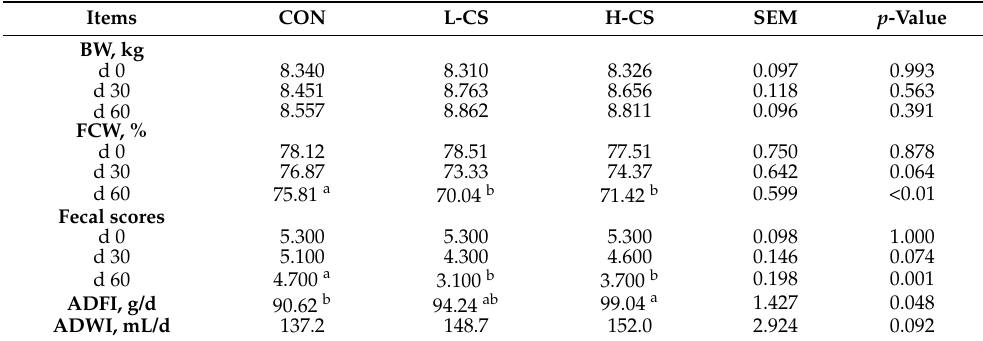
Table 2. Effect of chitosan on physical characteristics of cats.